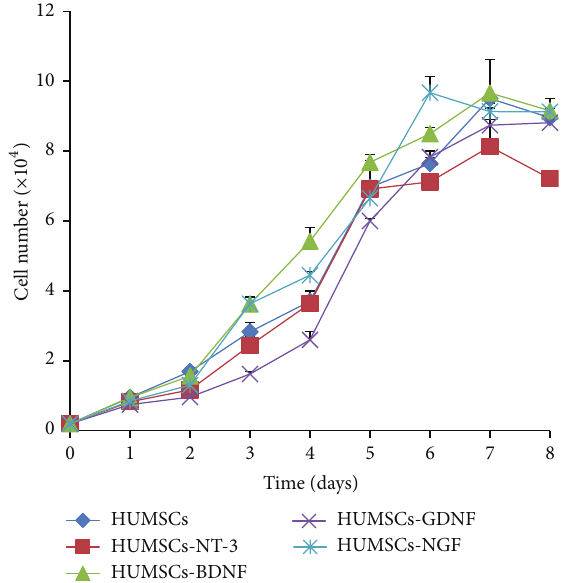
Figure 3: Cell growth curve of control and modified HUMSCs (P 5 , 𝑛 = 3